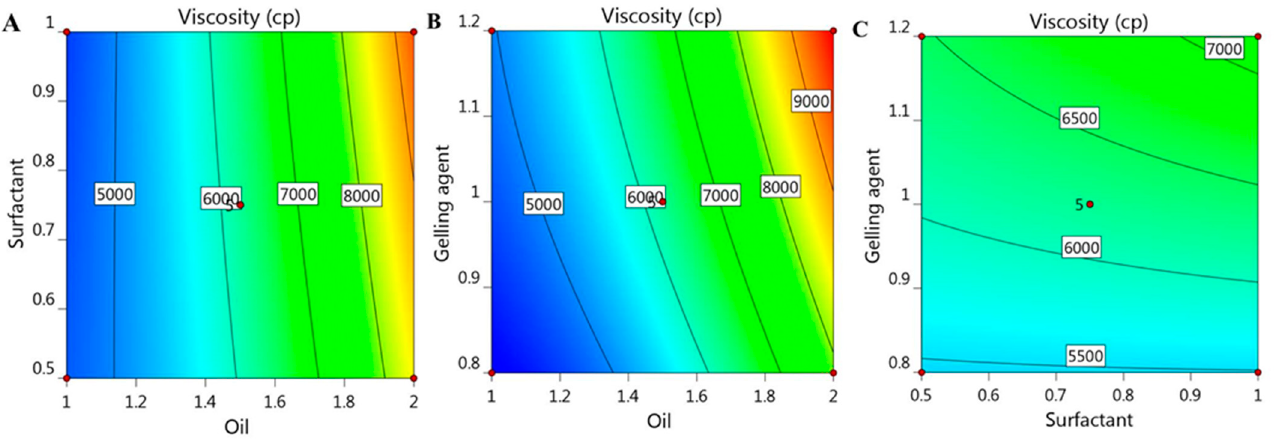
Figure 3. 2D contour graph representing the effect of independent factors ( A ) X 1 and X 2 , ( B ) X 1 and X 3 , and ( C ) X 2 and X 3 on viscosity responses (R 1 ).